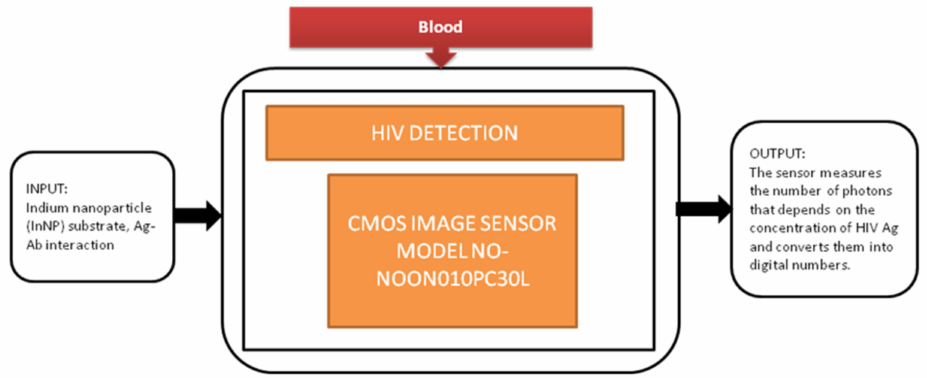
Figure 10. CMOS image sensor-based human immunodeficiency virus (HIV) detection. Diabetes is the most common disease, which is increasing rapidly across the world.